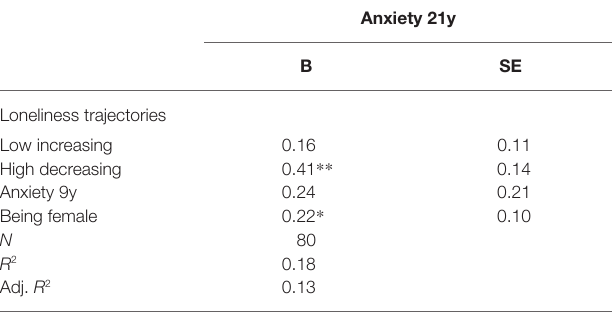
FIGURE 1 | Five quality criteria for the two-, three-, and four-cluster solution as computed by the kml method.